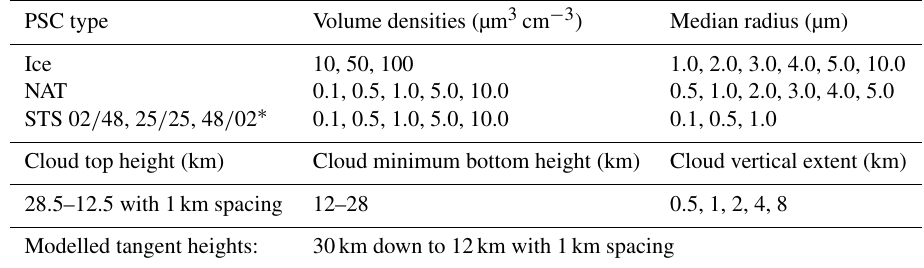
Table 1. Summary of cloud scenario database parameter